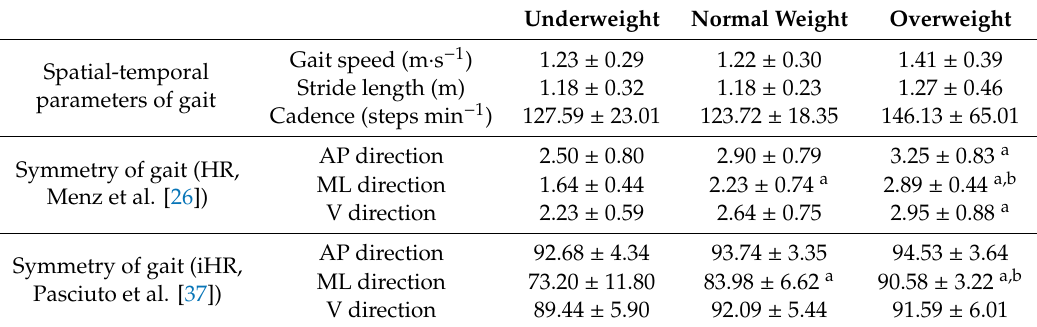
Table 2. Spatio-temporal and symmetry-of-gait parameters calculated for underweight, normal weight and overweight participants. Values are expressed as mean ± SD.